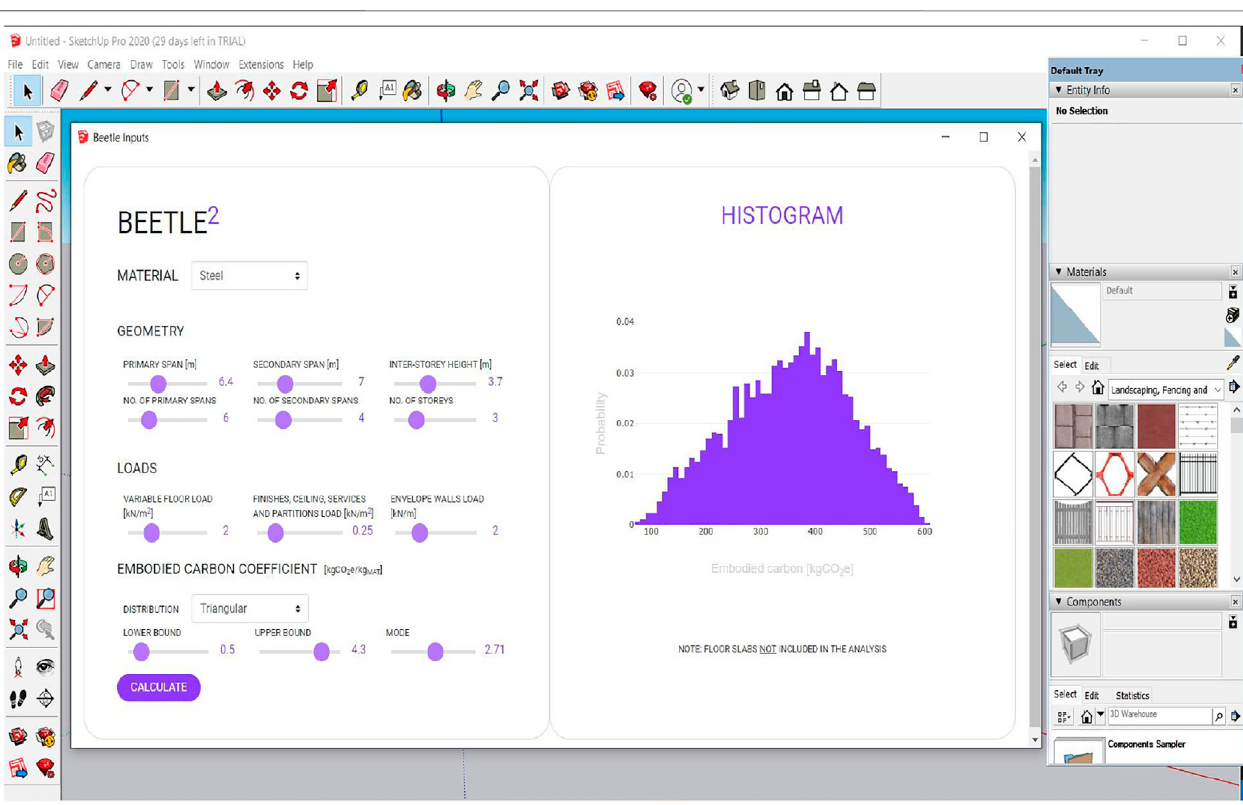
Frontiers in Built Environment |